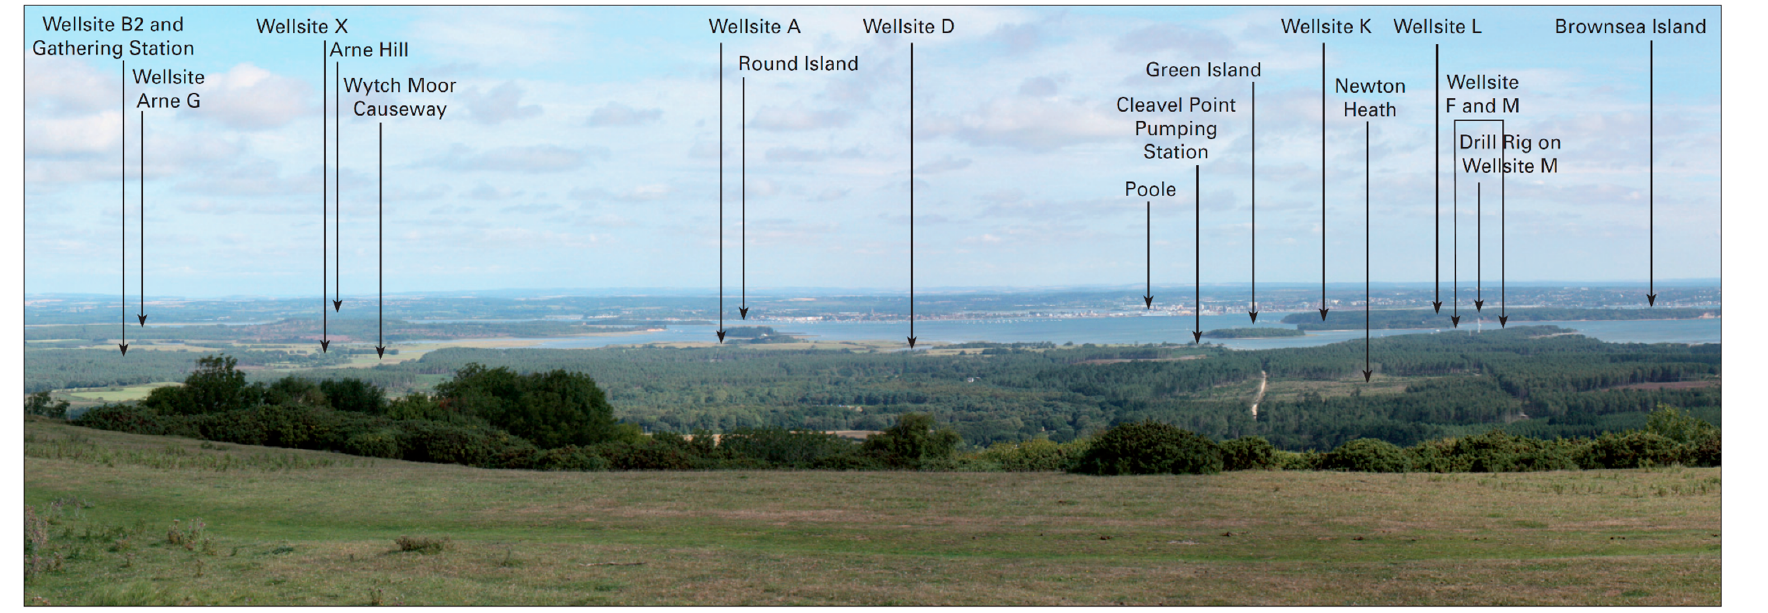
Figure 12. View looking northward from Ailwood Down (circa BNG reference SY 99562 81558; see Figure 6 for location), part of the steeply north-dipping monoclinal ridge in Upper Cretaceous Chalk, which forms the southern margin of the Hampshire Basin. This monocline was formed during the Cenozoic as a result of reverse-slip reactivation of a south-dipping Mesozoic normal fault (e.g., [61]). This panoramic view (from [56]) shows Wytch Farm oilfield sites hidden in the landscape of coniferous forest and heathland characteristic of the Hampshire Basin interior. The Wytch Farm gathering station (Figure 6) occupies a ~8 hectare site in the forest, in the locality marked near the western edge of this view, but is not visible in this photo. This oilfield won The Queen's Award for Environmental Achievement in 1995 and remains largely unnoticed by the general public, as the planners had hoped. Further details of the structural geology, petroleum geology, and environmental setting of this oilfield are provided by [98].